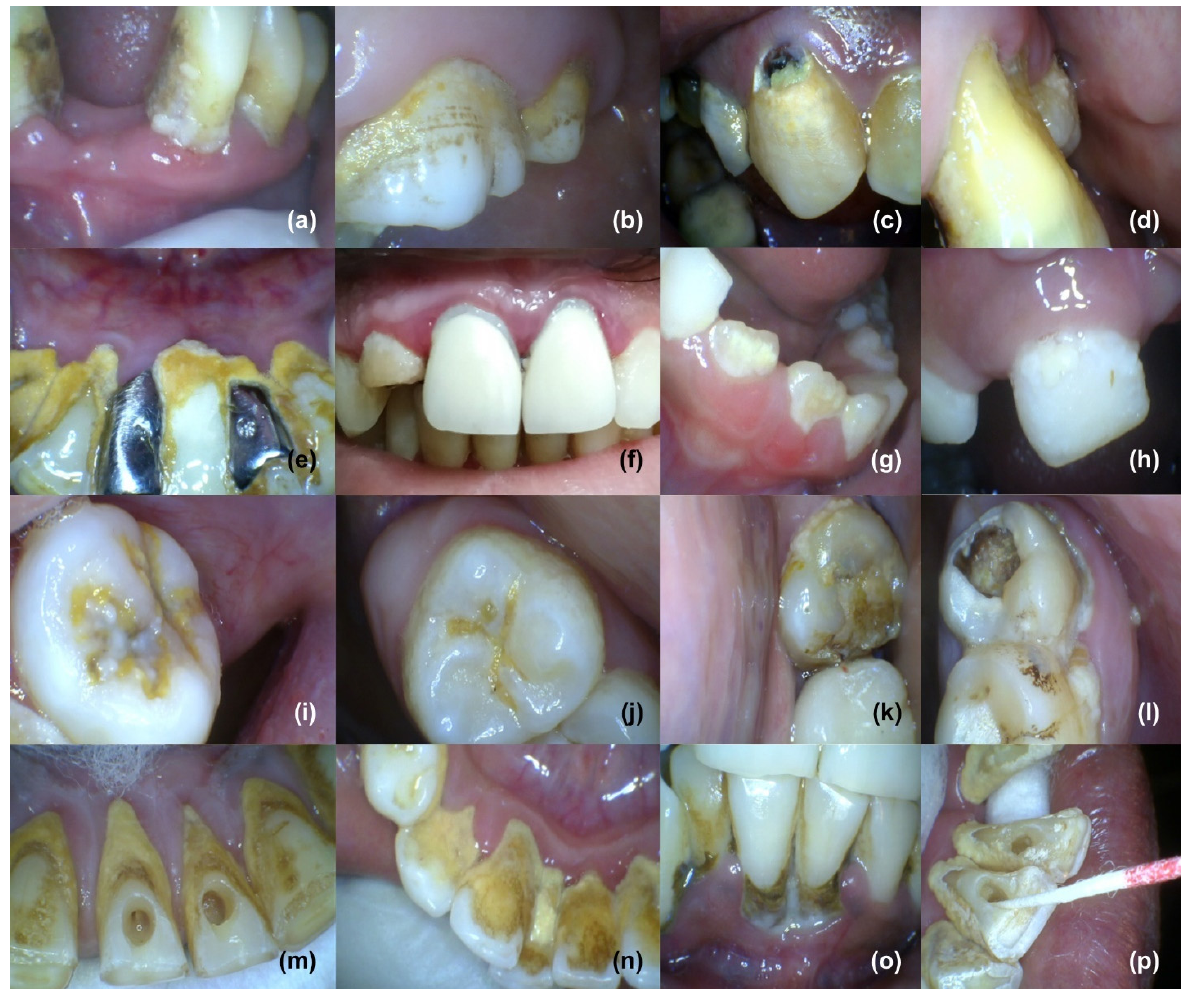
Figure 2. Biofilm on human teeth in the form of plaque and/or calcified plaque (calculus): soft plaque at the neck (near gingiva), crown (more towards gingiva), and more permeable dentogingival junction area of human teeth ( a – d ). Dentogingival junction can be seen shifted towards cemento-enamel junction ( a , d ), providing more surface for biofilm deposition, exposure of dentine area, and serving as an easy route for passage of bacterial products from biofilm into deep tissues. Hard (calcified) plaque or calculus on artificial surfaces of prosthetic teeth (dental crown or fixed partial denture): more calcified plaque can be seen near the dentogingival junction area, as compared to the crown of prosthetic teeth, and gingival inflammation (gingivitis) of free gingiva may also be seen ( e , f ). Plaque on early secondary or permanent, as well as primary, teeth ( g , h ). Calcified or hard plaque on the occlusal area forms mainly in pits, fissures, fossae, and grooves of permanent human teeth ( i , j ). Change in color of plaque can also be seen, indicating entrapment of minerals from saliva into biofilm and hardening, and soft as well as hard plaque on occlusal, interdental, dentogingival, and cervical areas of permanent human molar teeth ( k , l ). Very hard plaque of dark yellow, light yellow, or brown in color near the dentogingival, interdental, and cervical areas of permanent human lower anterior teeth ( m – p ). V-shaped shifting of dentogingival junction and free gingiva away from the neck of the teeth, towards the cemento-enamel junction, can also be seen. (Intraoral and dental pictures were provided by Dr. Mamta of Mamta Dental Clinic, Faridabad, India).